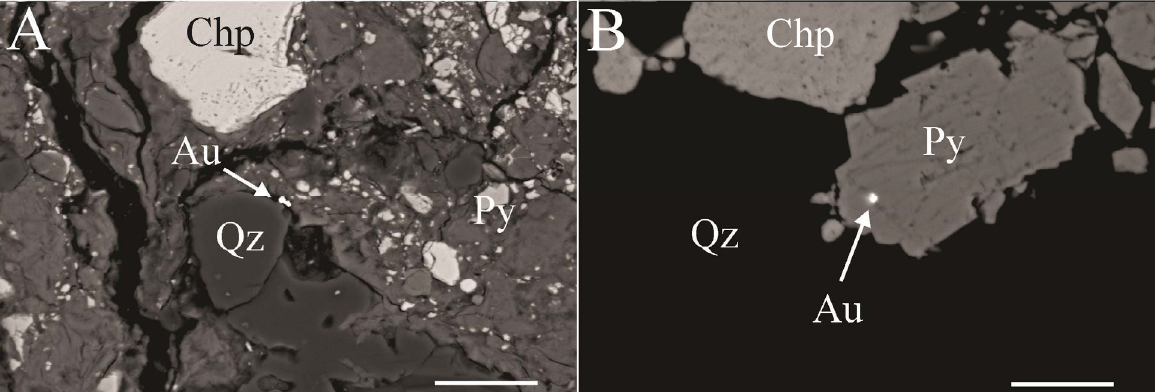
Figure 5. Backscatter electron images of gold grains from Cantiere Donnini: ( A ) detrital gold in the clastic accumulate sulfide and ( B ) small bleb of gold included in pyrite. Scale